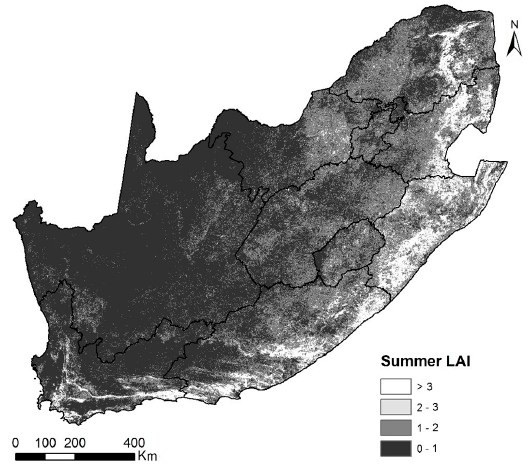
Figure 4. Leaf area index map of South Africa (Julian day 73) generated by inversion of PROSAIL radiative transfer model on MODIS imagery.